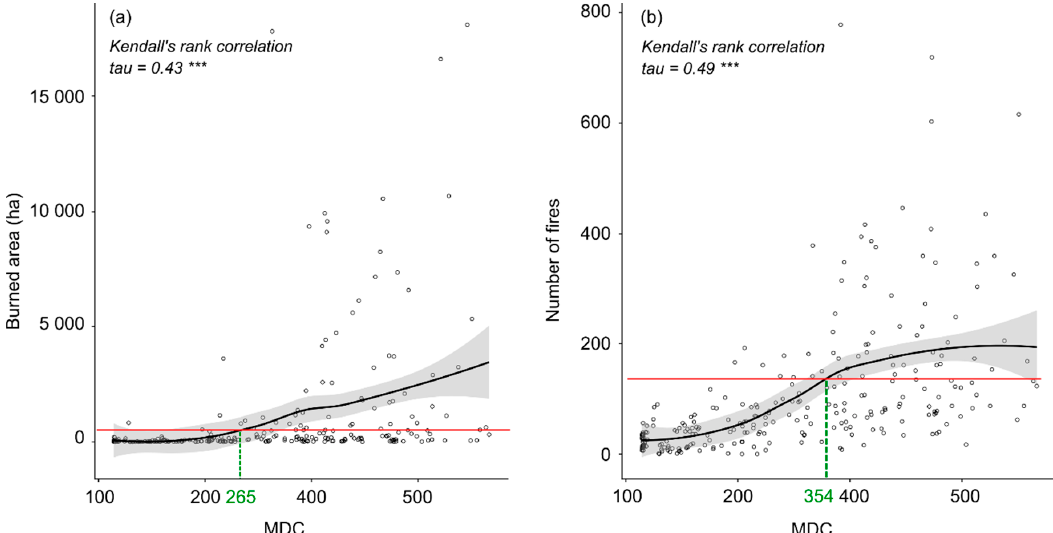
Figure A6. Relationship between MDC and total burned area ( a ) or the number of fires ( b ) between April and October over the 1979–2016 period. Each trend was calculated using the LOESS method. In both panels, the red line represents the most fire-prone months (fourth quartile), while the green line points to the corresponding MDC value. These “local threshold values” corresponding to the most fire-prone months were 265 and 354 (for burned area and number of fires, respectively), averaging 310 units, which is very close to the 300 unit threshold value estimated from DC.